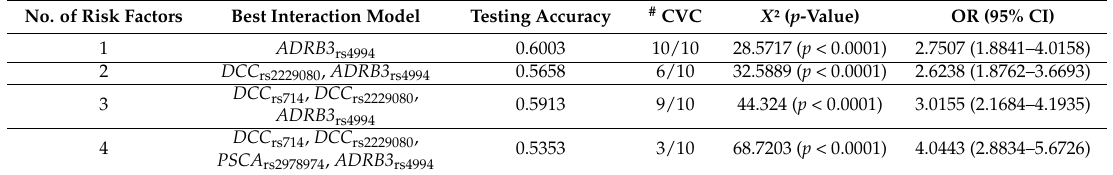
Table 3. Multifactor dimensionality reduction (MDR) analysis showing association of high-order interactions with